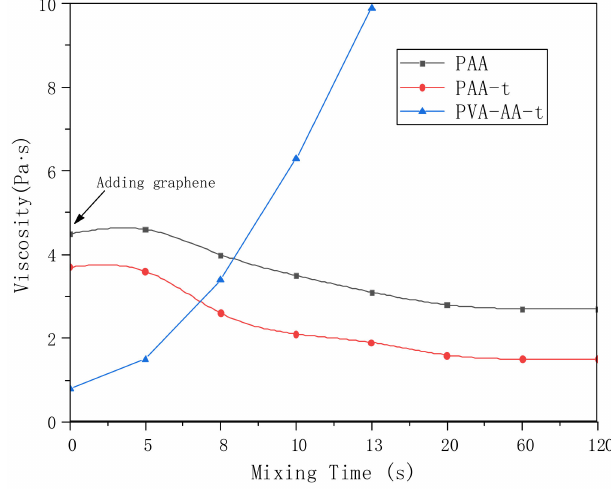
Figure 11. The changes in the viscosity of graphene dispersion slurry (polymer concentration: PAA: 1%; PAA-t: 1%; PVA-AA-t: 0.1%; Gr: 0.5%).